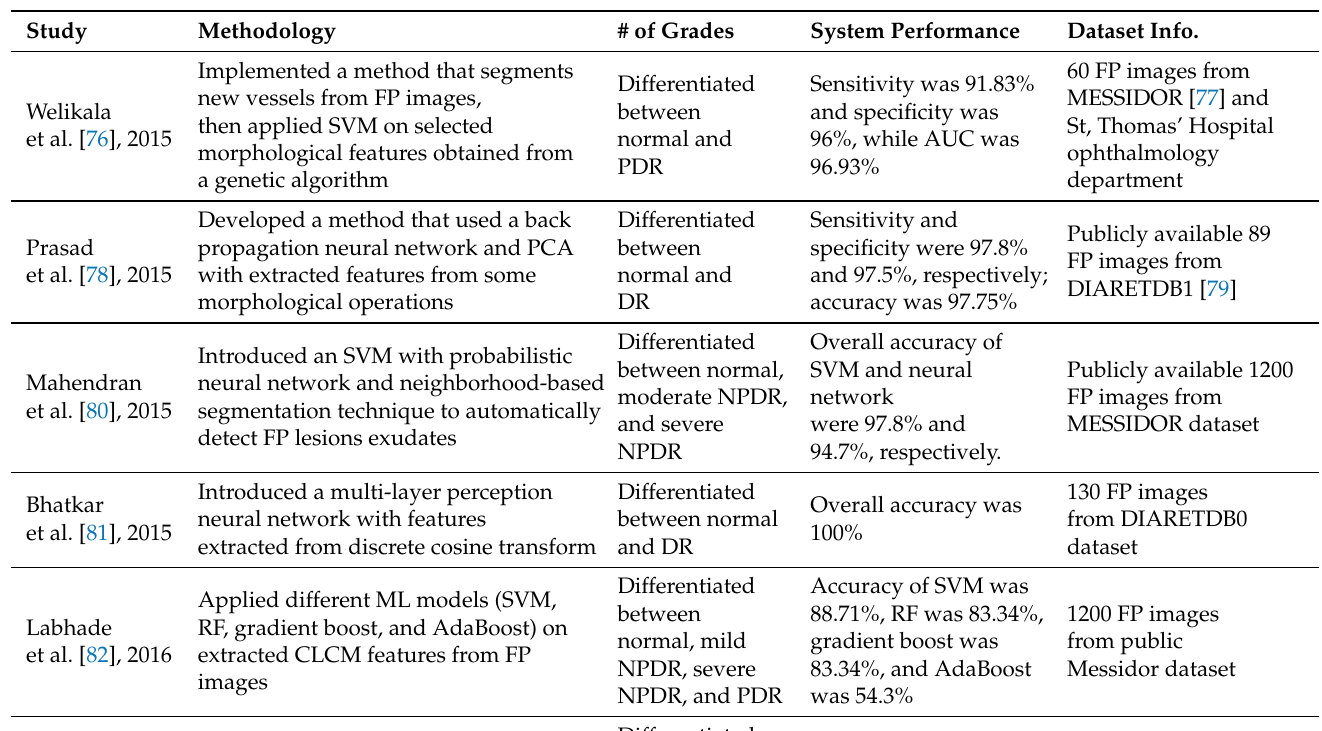
Table 2. Recent studies for early detection and grading of DR based on a combination of image processing, ML, and DL